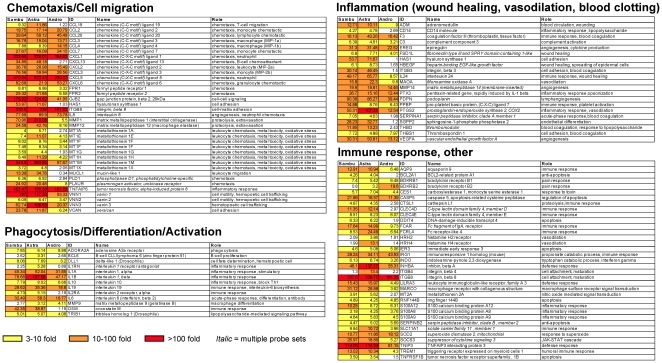
Host gene expression regulated by Astragalus membranaceus treatment of PBMCs.Genes were sorted based on a threefold (P<0.01) or greater level of induction for Astragalus treated PBMCs for 18 hours (Astra column). Only genes involved in the immune/inflammatory response are shown. Changes (n-fold) in expression level relative to those of ethanol-treated cells are shown within each box. Red boxes represent genes induced 100-fold or higher, orange boxes represent genes induced 10 to 100-fold, and yellow boxes represent genes induced 3 to 10-fold. Additional botanical treatments include Sambucus cerulea (Sambu column) and Andrographis paniculata (Andro column).